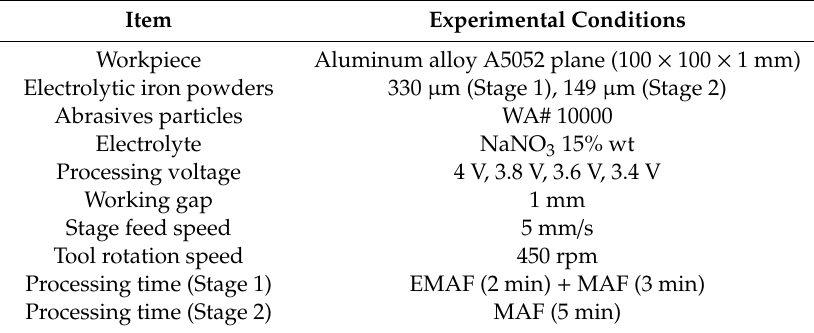
Table 4. EMAF experimental conditions for optimization of processing